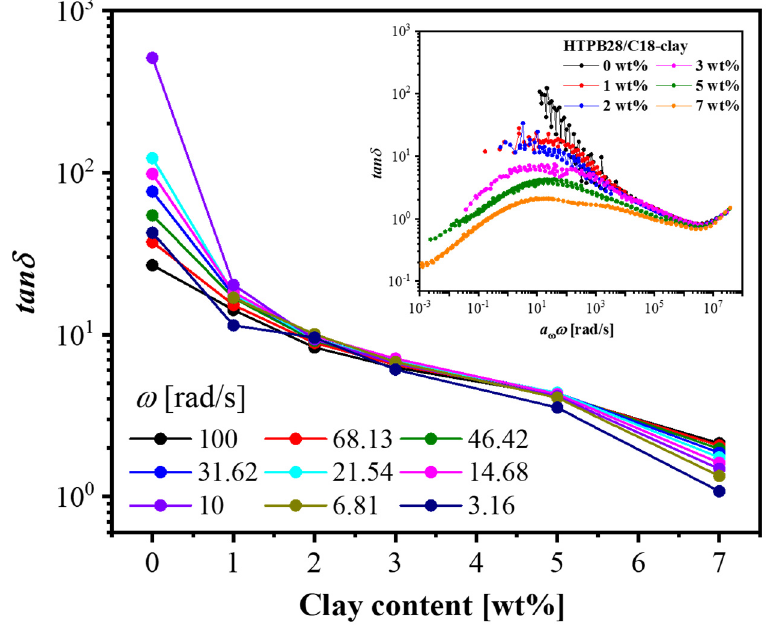
Figure 1. Plots of loss factor tan δ in a frequency range from 100 rad/s to 1 rad/s (black to purple) as a function of clay content (conducted at 20 °C). (Inset) tan δ as a function of angular frequency ( T ref a function of clay content (conducted at 20 ◦ C). (Inset) tan δ as a function of angular frequency ( T ref was 20 °C). was 20 ◦